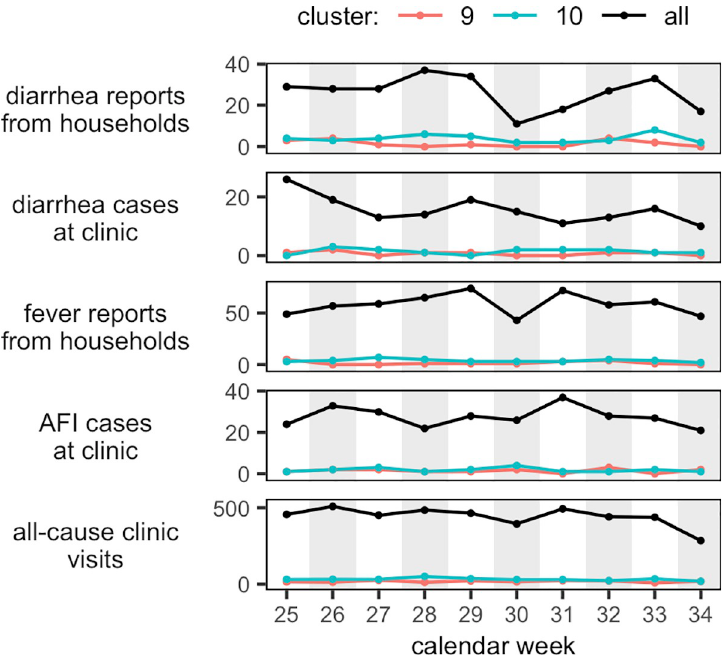
Fig 2. Data from the PBIDS from the Kibera clusters 9 and 10 in the period from June 18, 2014 (week 25) to August 20, 2014 (week 34). All cluster: black; cluster 9: red; cluster 10: green; X-axis is cases.